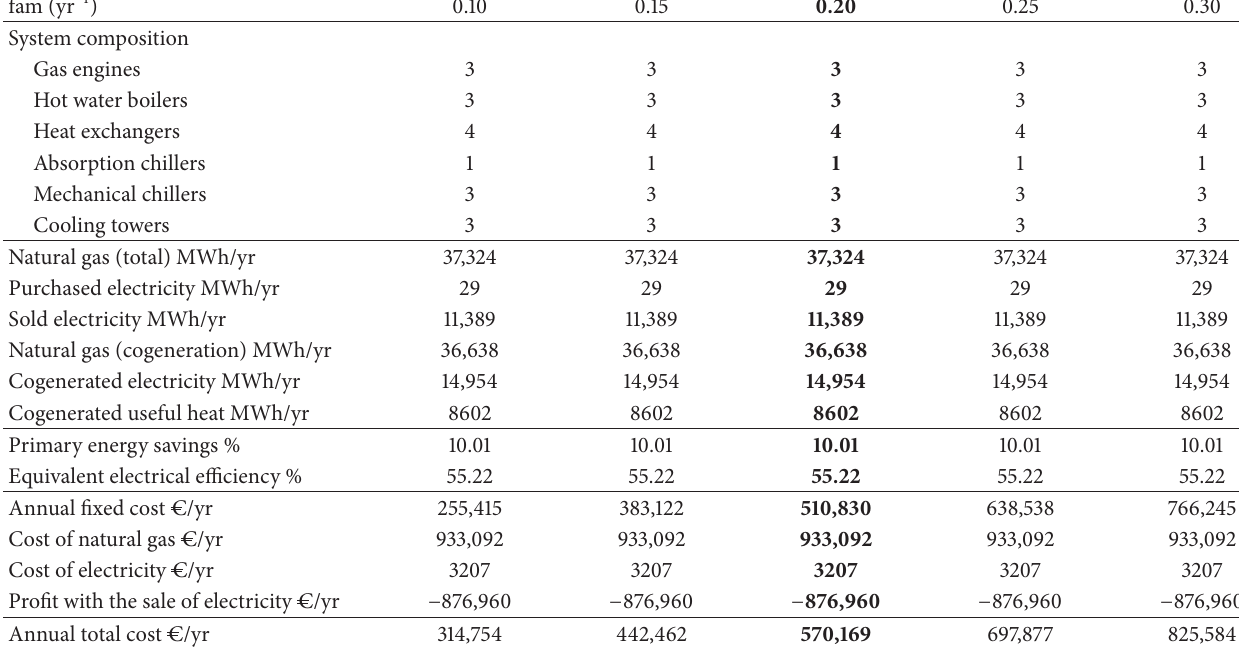
Table 6: Sensitivity analysis for fam considering the base case configuration.